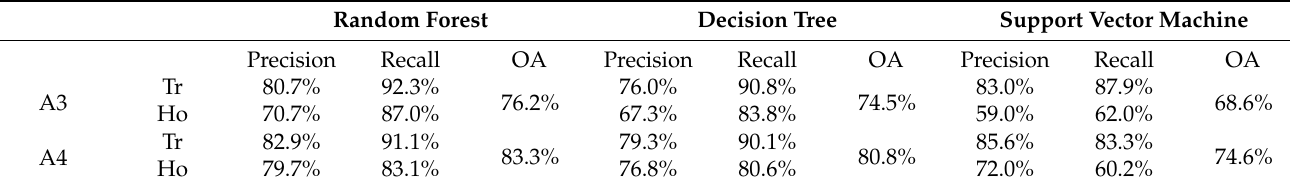
Figure 7. Classification results of different models in training area A4: ( a , d ) are the classification results of the RF model from a top and side view, respectively; ( b , e ) are the classification results of the DT model from a top and side view, respectively; ( c , f ) are the classification results of the SVM model from a top and side view, respectively. Table 3. Accuracy table of the classification results of these three different